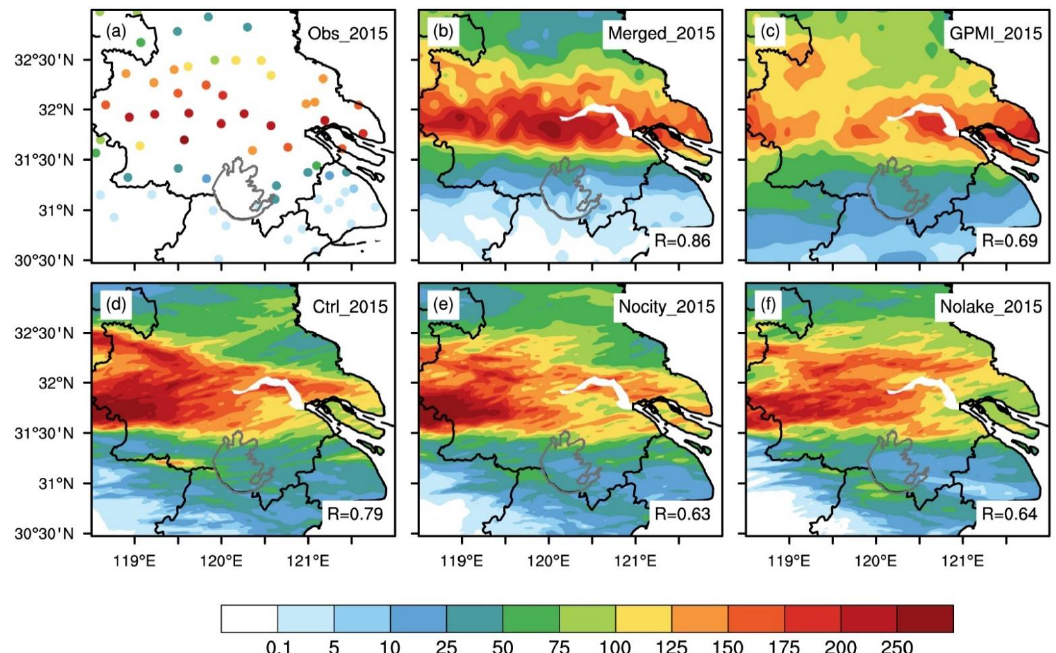
Figure 1. The distributions of the daily precipitation (unit: mm) for ( a ) the station observations, ( b ) the Merged, ( c ) the GPMI and ( d – f ) three simulations (control, Nocity, and Nolake) for EP627. The right-bottom R denotes the spatial correlation coefficients between the observation and the corresponding dataset.